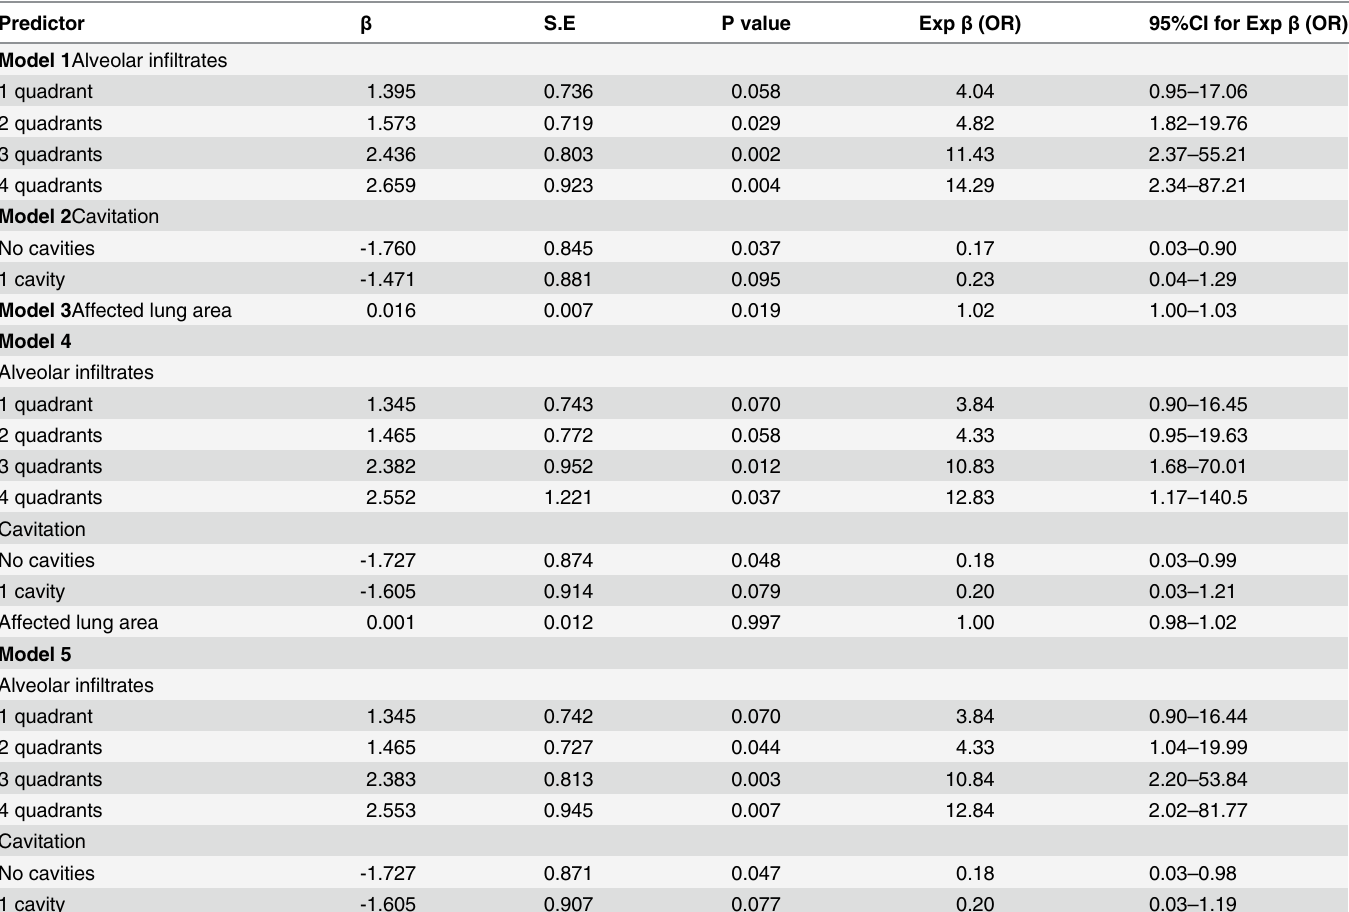
Table 6. Univariable and multivariable ordinal regression: association of alveolar infiltrates and cavities with number of bacteria in sputum smear.